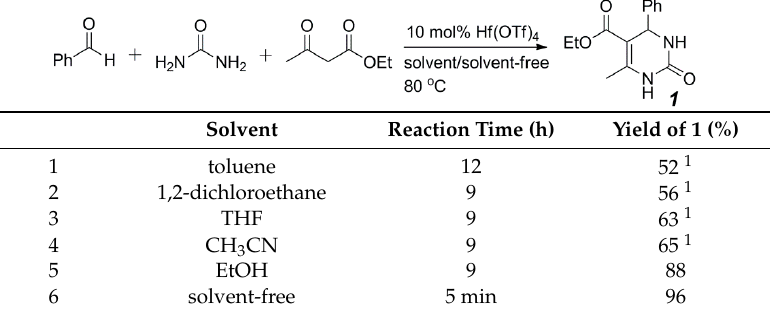
Table 2. Solvent effect on the Hf(OTf) 4 -catalyzed Biginelli reaction.